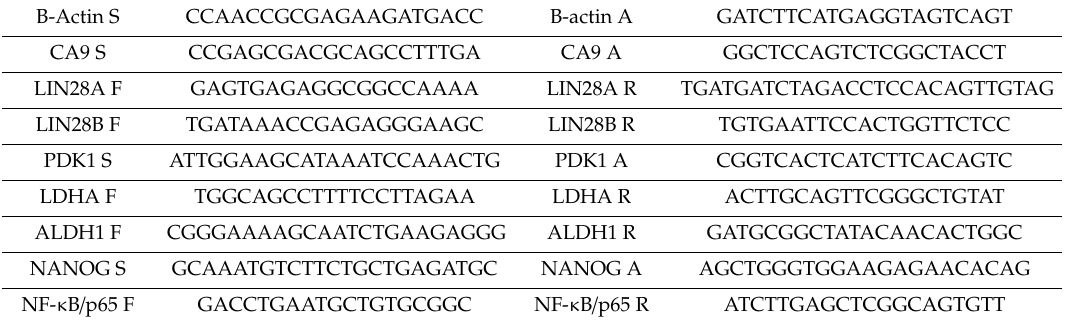
Table 3. List of primers (5 (cid:48) –3 (cid:48)